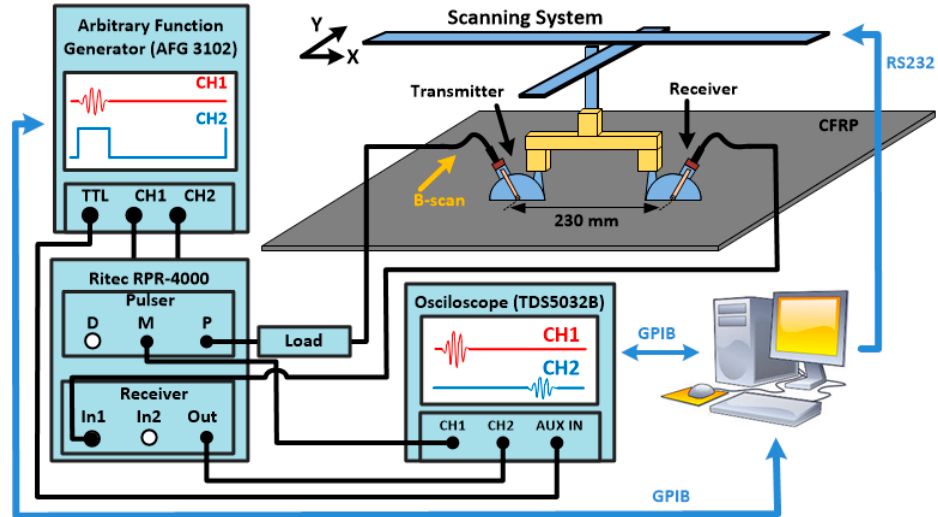
Figure 2. Experimental setup for guided wave testing, depicting the B-scan at 90°.